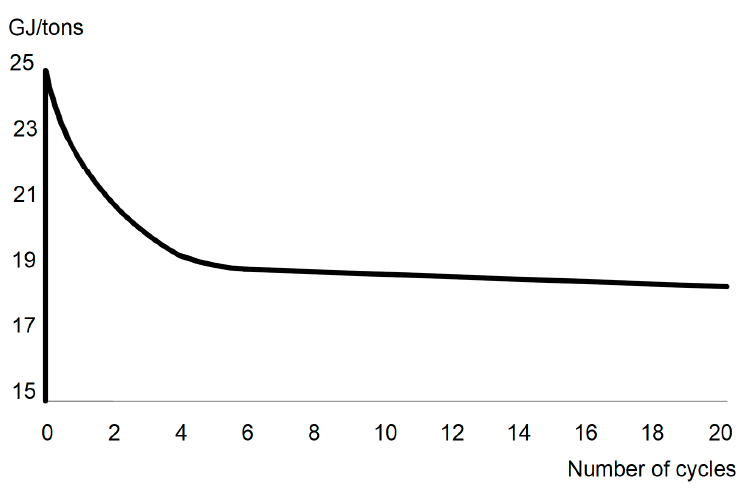
Figure 2. Energy use per 1 t of steel produced in each recycle.